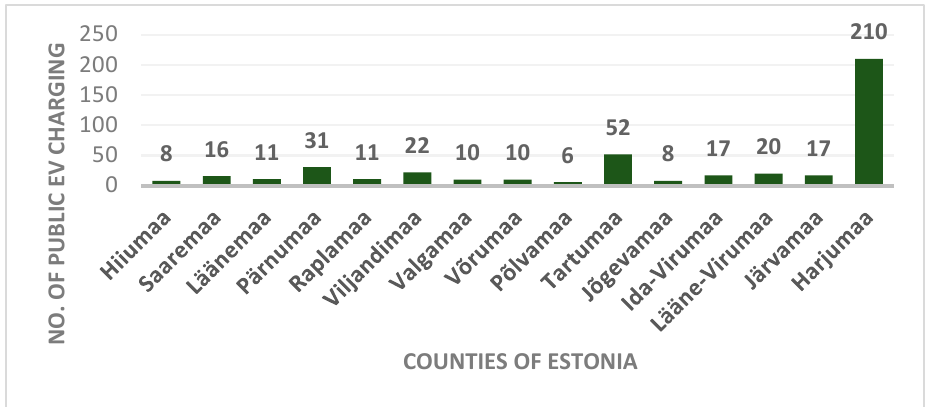
Figure 6. Public charging stations in different counties of Estonia [103].